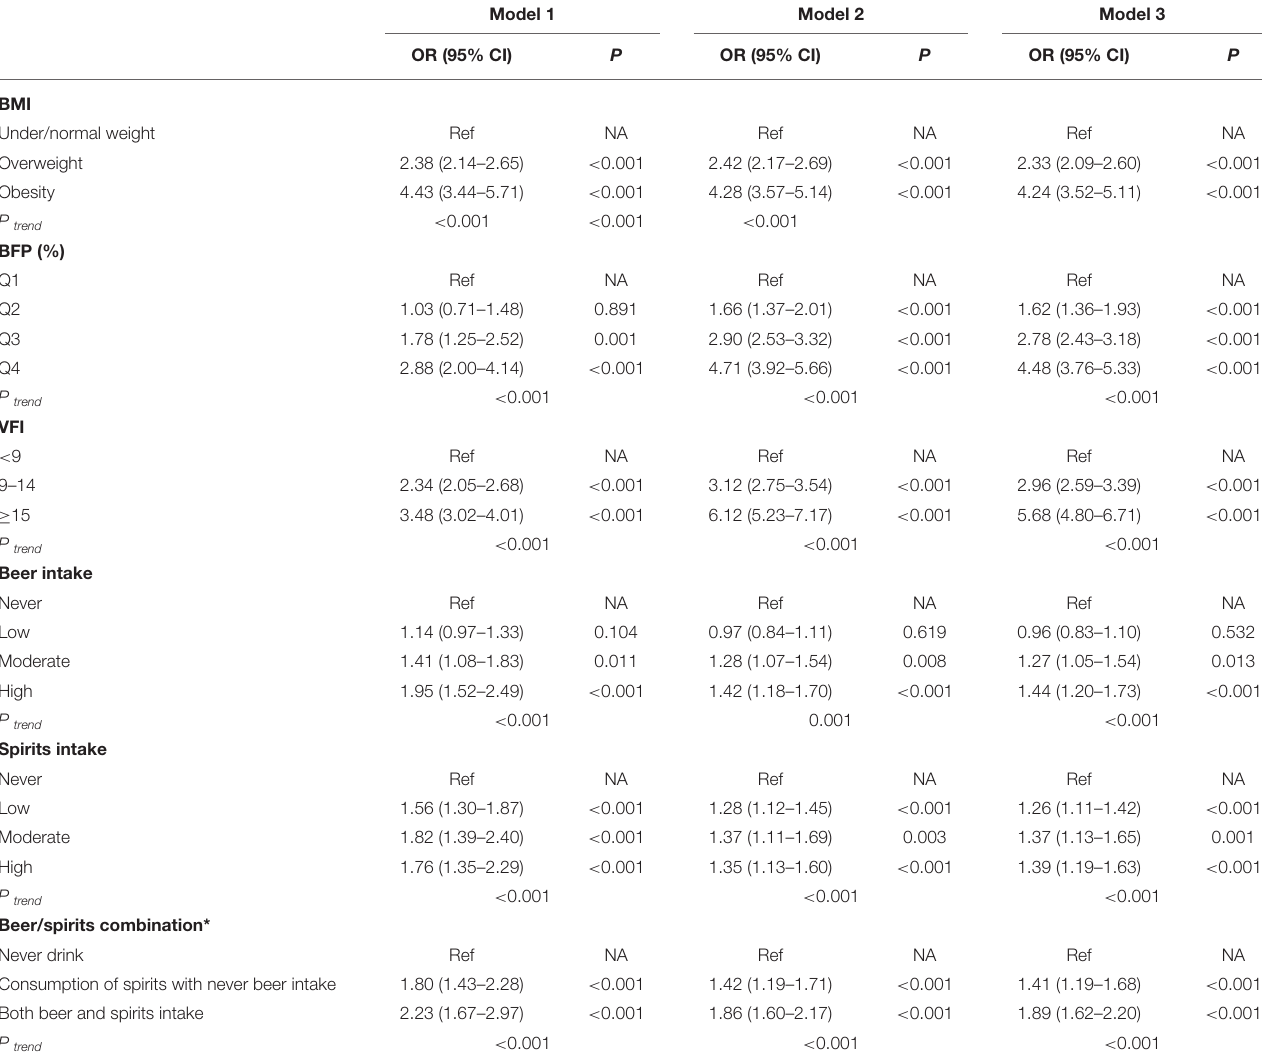
TABLE 3 | The effect of excess adiposity and alcohol use on hyperuricemia (HUA) among male participants ( n =